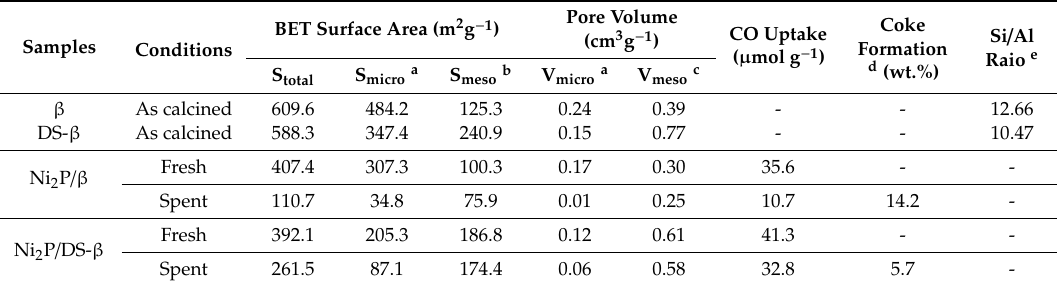
Table 1. Physical properties of the support and Ni 2 P